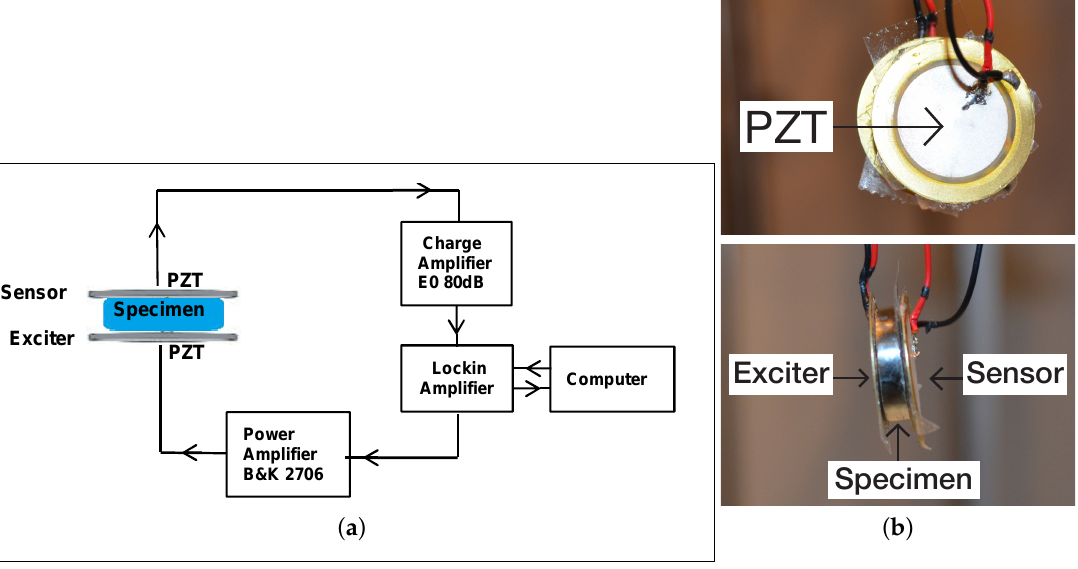
Figure 2. The second vibration spectroscopy experimental setup. ( a ) diagram of the setup employed; ( b ) upper panel, side view photograph of the piezoelectric exciter and sensor, lower panel, front view of the thick disc alloy specimen placed between the piezoelectric exciter and the sensor